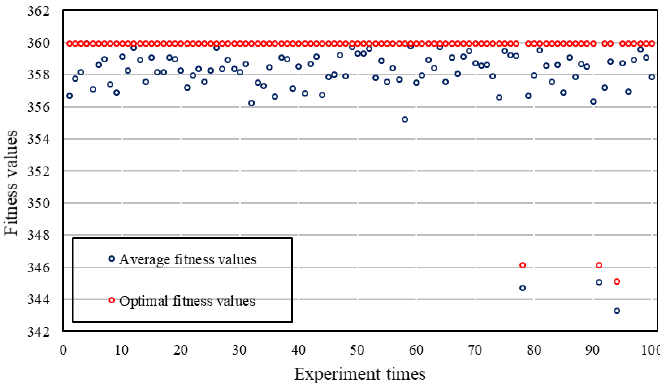
Figure 12. Optimal Fitness Values in 100 Experimental Results.